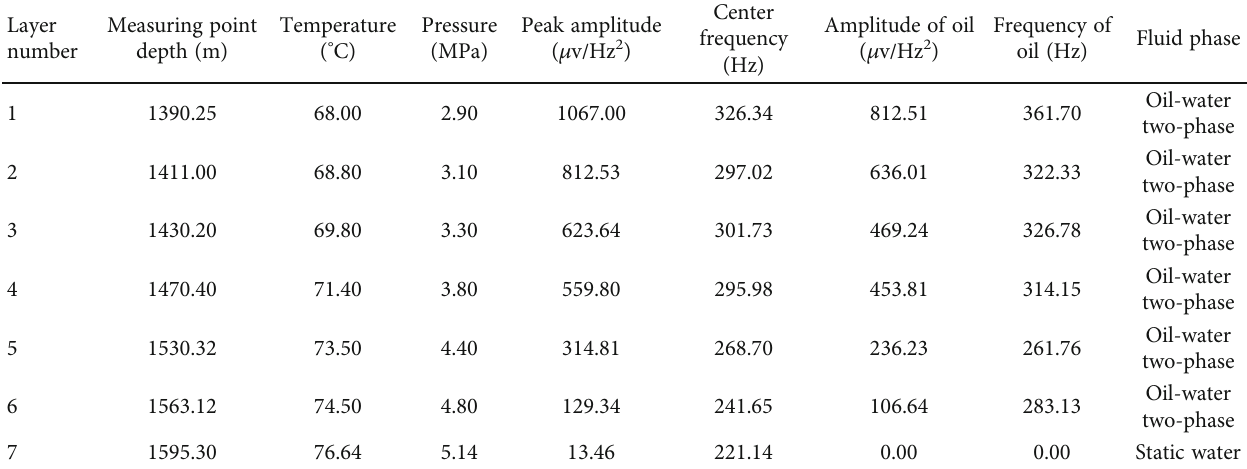
Table 6: Well 13-1-2 power spectrum characteristic parameter